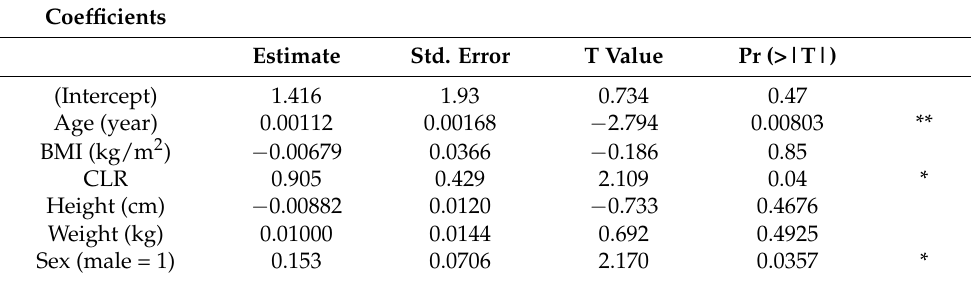
Table 5. Logistic regression of the algorithm obtained from the Hungarian patients on the femoral total Femur.